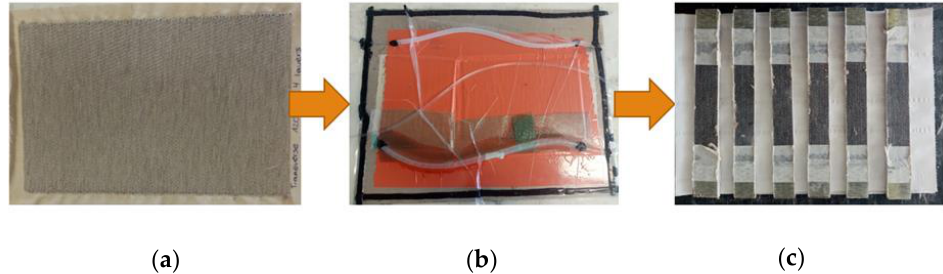
Figure 4. Stages of production of test samples. ( a ): dry sample; ( b ): making a composite; ( c ) : cutting into samples of an appropriate size (own source).